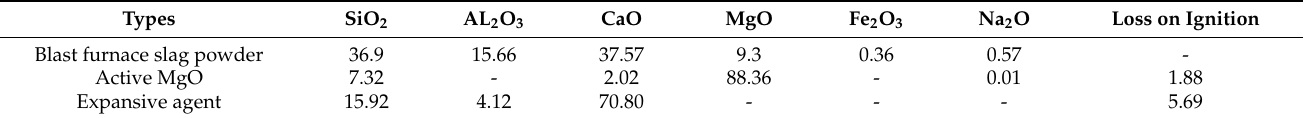
Table 1. Main chemical composition of raw materials (%).